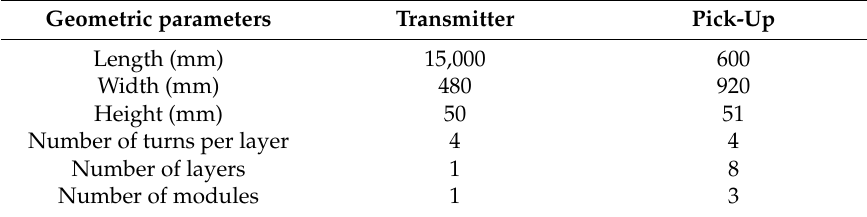
Table 2. Summary of the designed transmitter and pick-up geometries. Table 3. Simulated and measured circuit parameters of the transmitter and the pick-up. Circuit Parameters